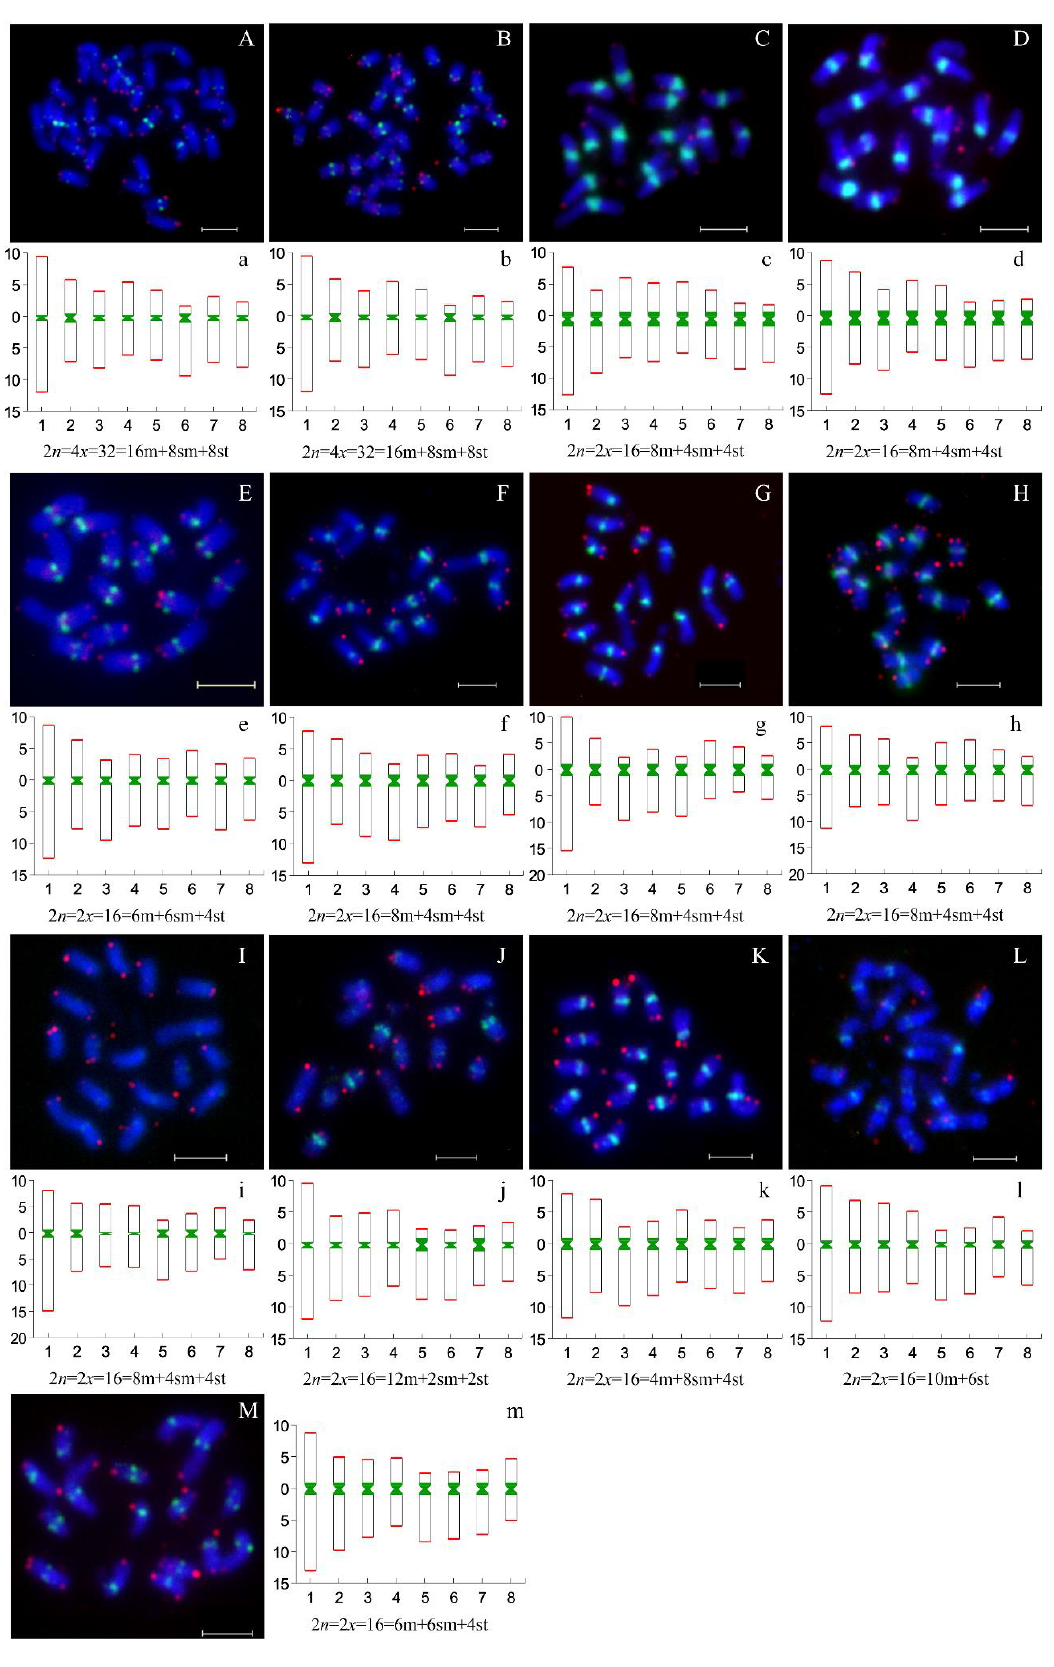
Figure 4. Chromosomal distribution of centromeres and telomeres among P. pseudocerasus and